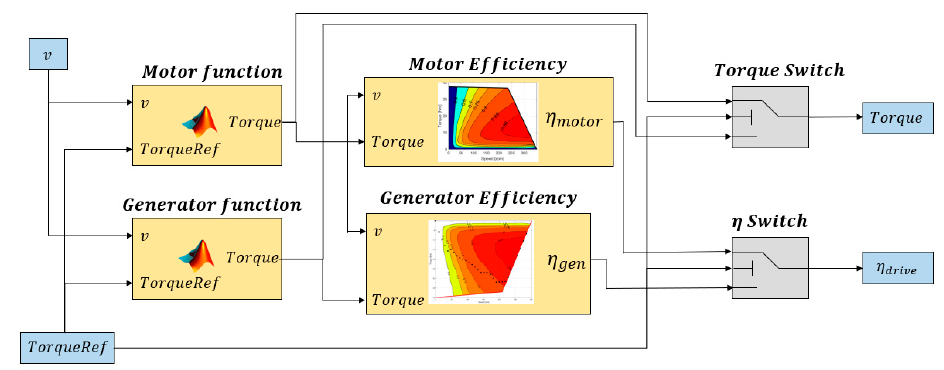
Figure 4. Overview of the powertrain subassembly in the optimization model.